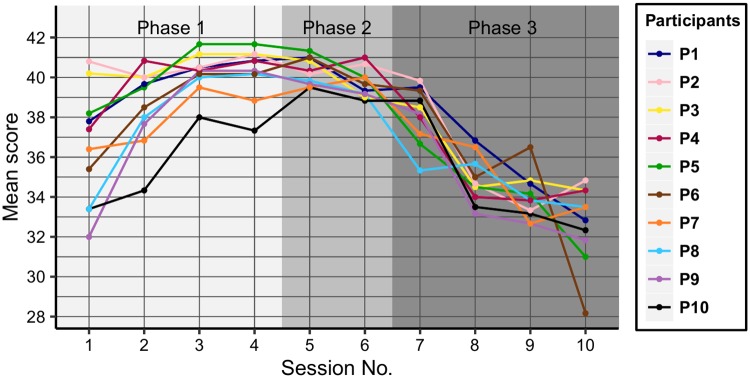
Mean scores across sessions.